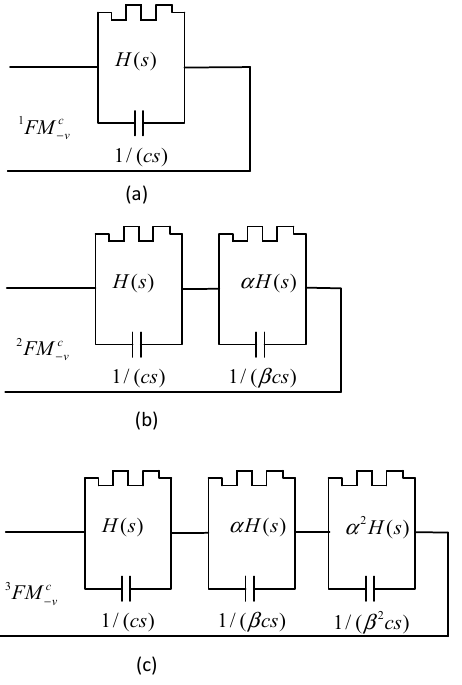
Figure 6. ( a ) First series LCSF; ( b ) second series LCSF; and ( c ) third series LCSF. Said another way, c − v H ( s ) is a scalar. Taking Equation (22) into Equation (21), we Then, obtain Equation (23), 1 0 Because LCSF is a low-pass filter, when s → 0, w = H ( s ) cs → 0. Equation (23) is approximated as Equation (24), By the general dynamical scaling law, which can be derived from Equation (15), the approximate solution to Equation (21) is